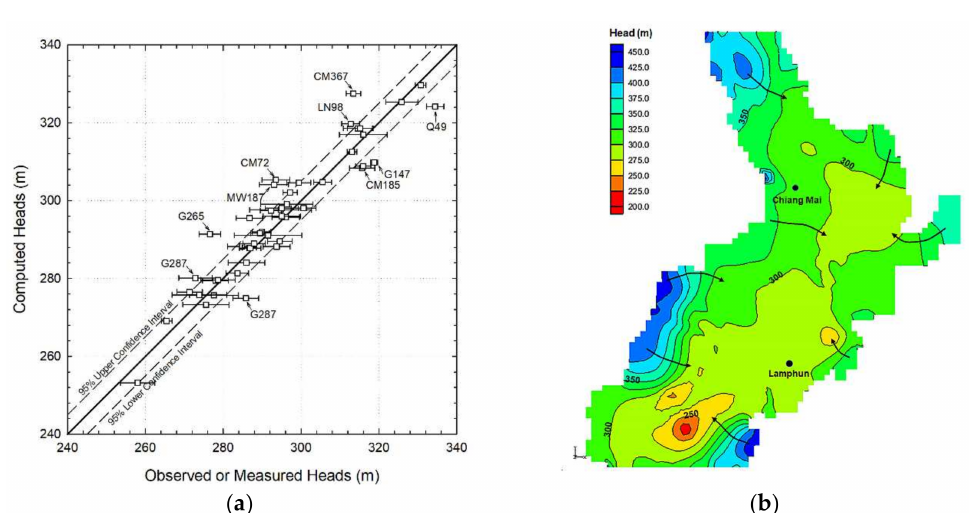
Figure 10. Steady-state model calibration results: ( a ) measured vs. model simulated hydraulic heads and ( b ) hydraulic head (m a.m.s.l.) contours after steady-state model